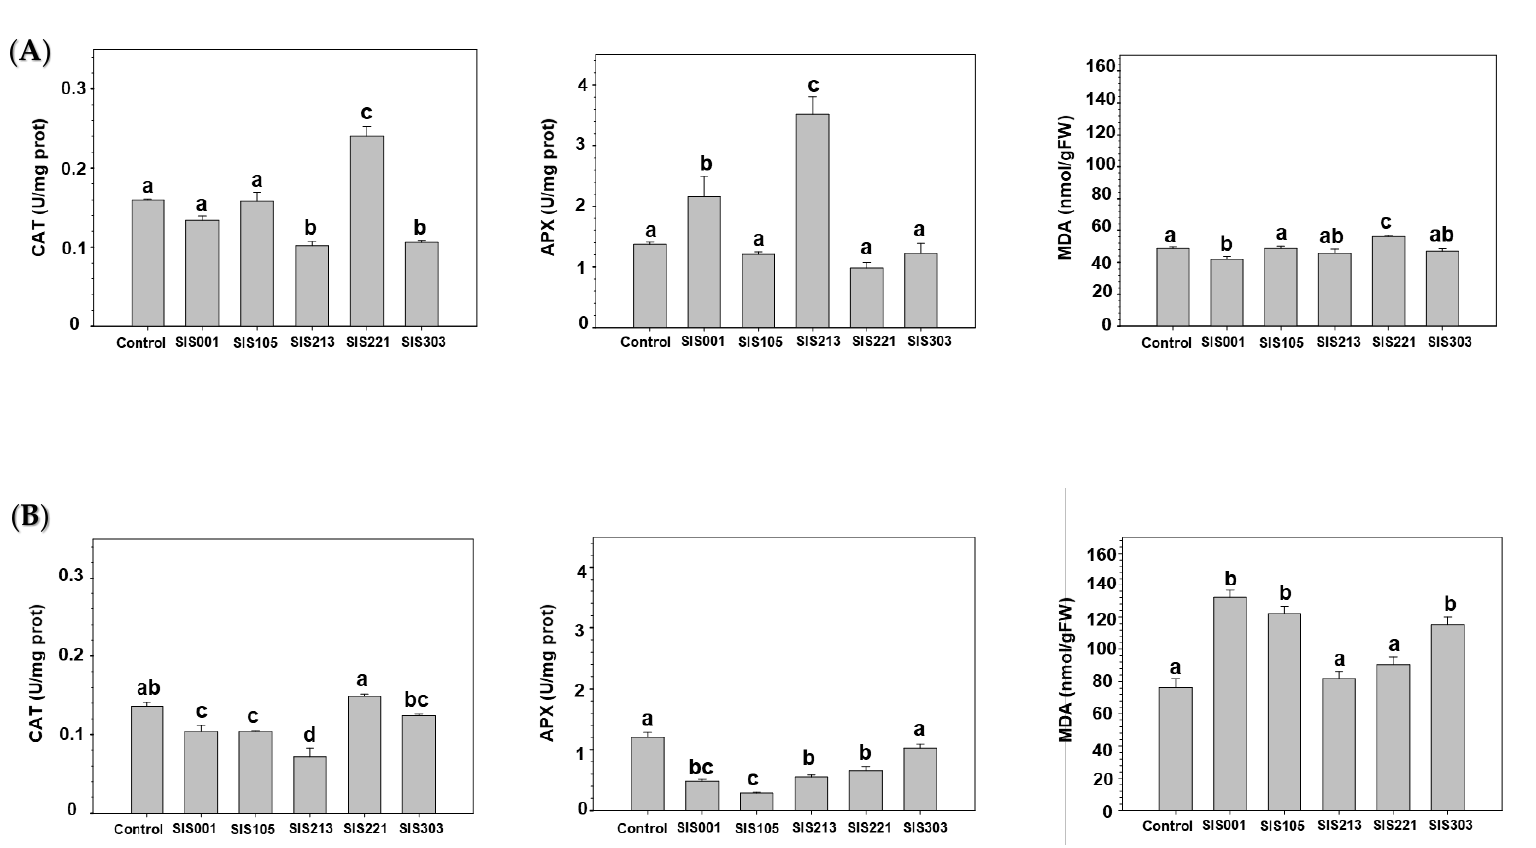
Figure 2. Effect of rhizobacteria inoculation on CAT, APX and MDA levels of ( A ) Tres Cantos and ( B ) cherry plants. Antioxidant activities CAT ( left ) and APX ( middle ), and MDA as an indicator for lipid peroxidation ( right ) were measured in leaves of tomato plants harvested 4 months after of inoculation. Data are the means ± SE of 3 replicates. Values marked with different letters within each panel are significantly different according to Duncan’s multiple range test, p < 0 . 05.